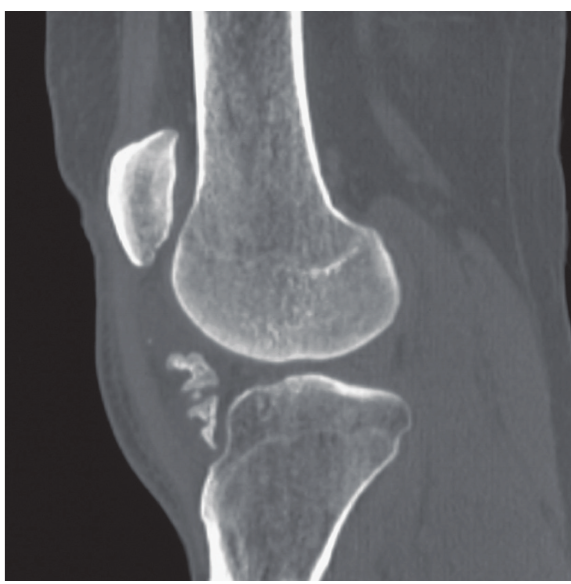
Figure 3: Computed tomography showing the mass with its osseous content in the infrapatellar region.